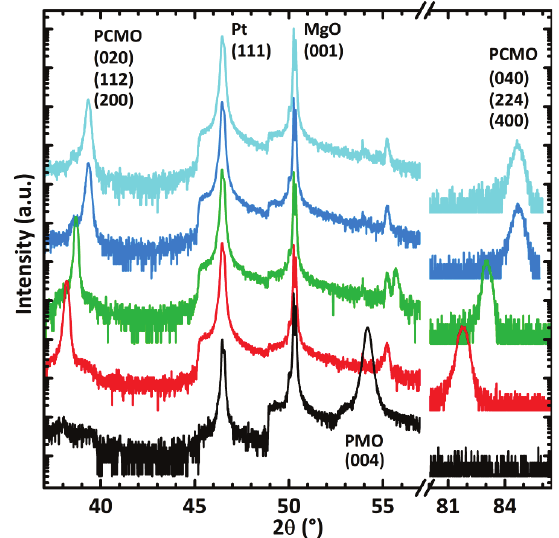
Figure 6. XRD scans in θ – 2θ geometry. The intense substrate peaks correspond to Pt (111) (black) exhibits a (001)/(110) twin structure, while samples with and MgO (001). PrMnO 3 x = 0.3 (red) and 0.5 (green), as well as the two samples with x Ca show a (100)/(010)/(112)